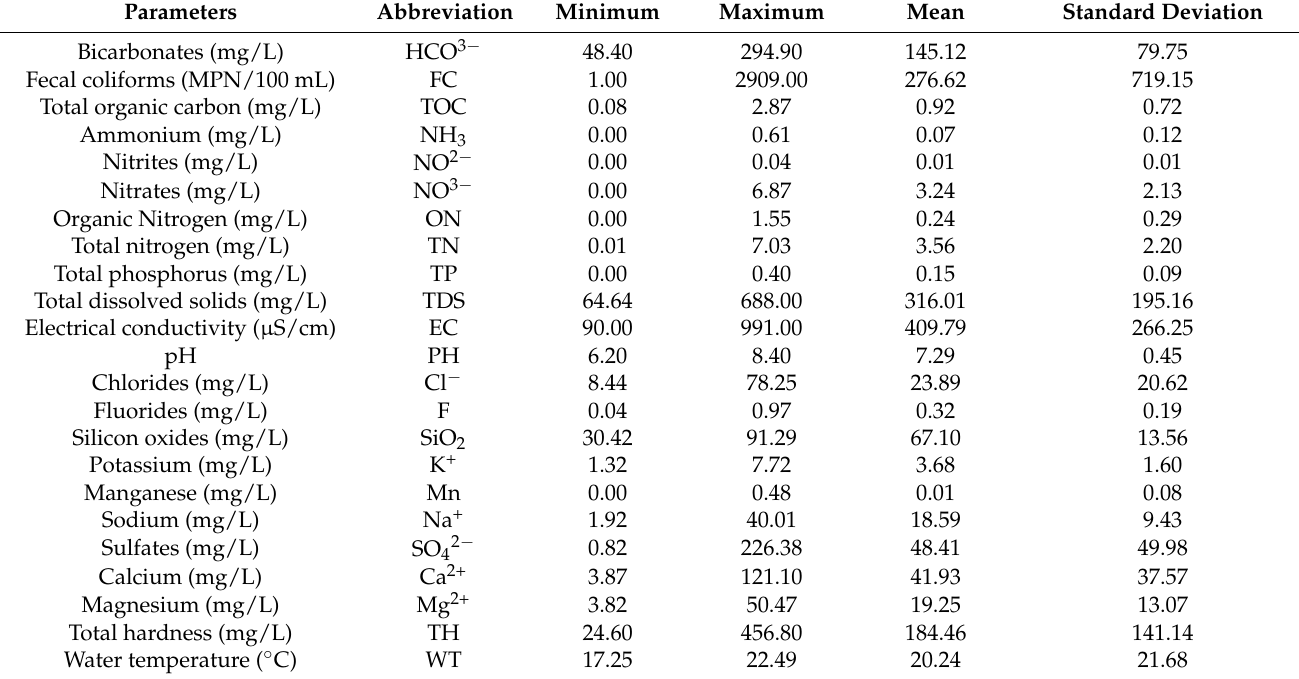
Table 2. Range, standard deviation and mean values for water quality parameters in the Cuernavaca aquifer from 2012 to